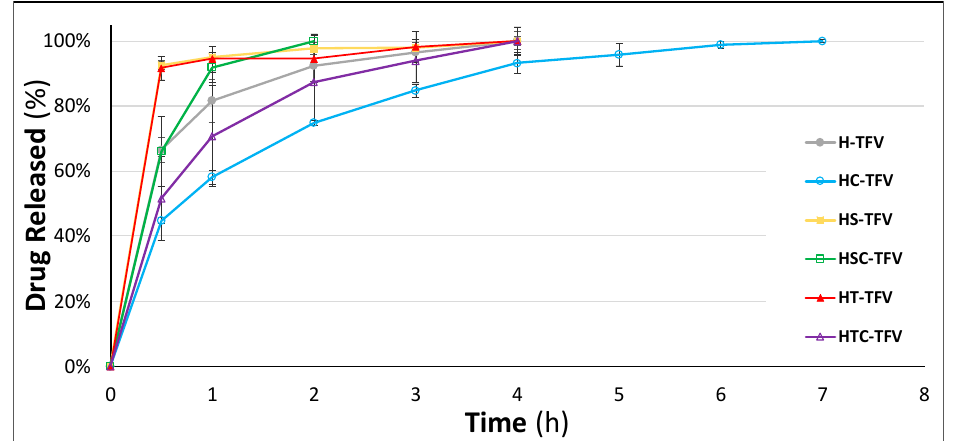
Figure 10. Drug release profiles of TFV-loaded vaginal discs in simulated vaginal fluid. Mean ± SD are presented ( n = 3).